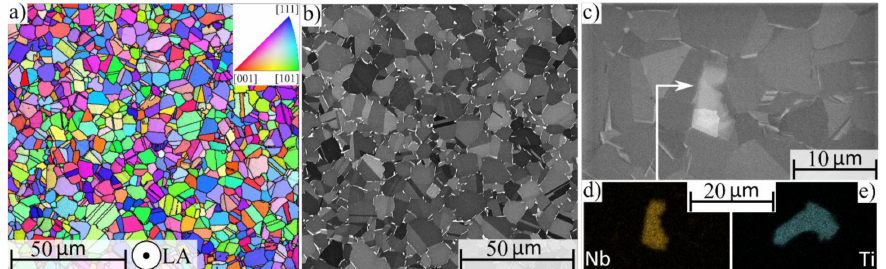
Figure 3. Investigation of the cross sections of the REF material. ( a ) Crystallographic orientation map with an orientation parallel to the LA in colour code according to the inverse pole figure. ( b ) BSE image of a cross section perpendicular to the load axis showing the δ -phase (bright). ( c ) BSE image of a cross section perpendicular to the load axis showing the Nb-rich inclusion. ( d ) EDS mapping measurement of the Nb-rich inclusion. ( e ) EDS mapping measurement of a Ti-rich